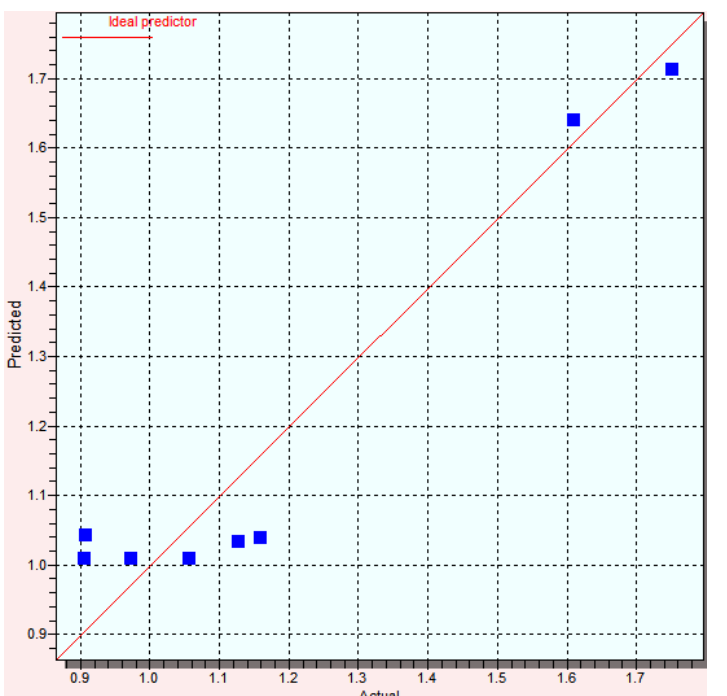
Figure 7. Calculated against experimental antiradical activity.